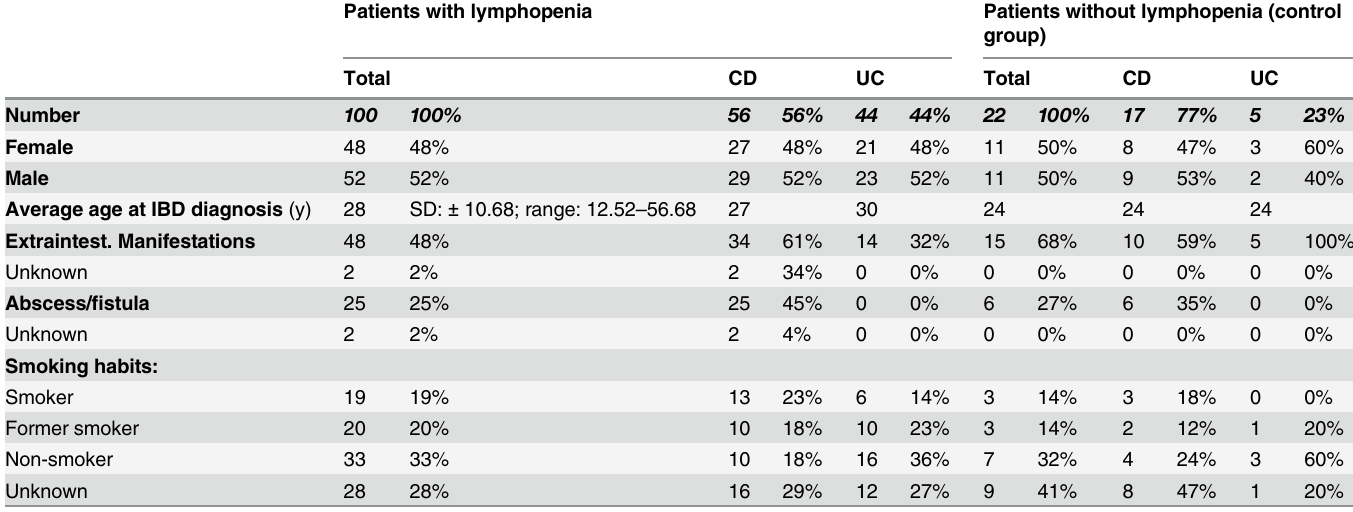
72 (72%) of all subjects. Interestingly, 13 (23.2%) CD patients but only 6 (13.6%) UC patients were smokers. In both groups, 10 (CD: 17.9%, UC: 22.7%) persons quit smoking sometime before development of lymphopenia and 10 (CD, 17.9%), respectively 16 (UC, 36.4%), were non-smokers. Table 1. Patient and disease characteristics. Patients with lymphopenia Patients without lymphopenia (control